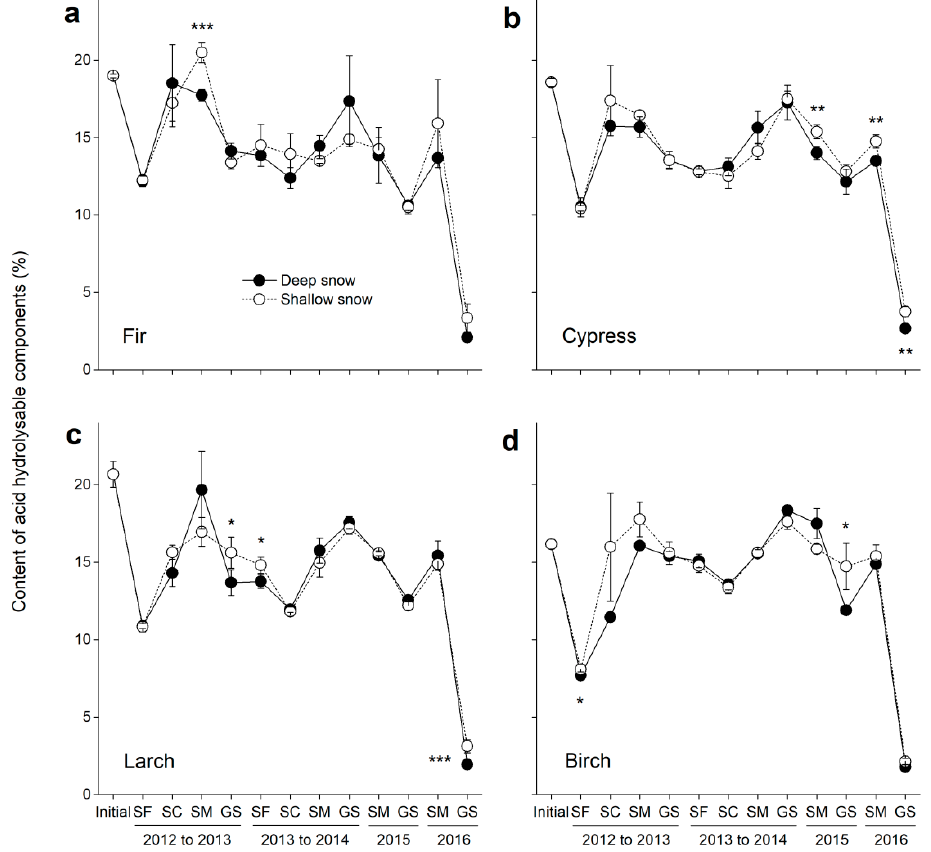
Figure 4. Contents of acid hydrolysable components (±SE, n = 6) in decomposing litter in the deep and shallow snow plots. ( a ) Fir, ( b ) cypress, ( c ) larch, and ( d ) birch. SF: snow formation stage, SC: snow coverage stage, SM: snowmelt stage, and GS: growing season. * p < 0.05, ** p < 0.01 and *** p < 0.001.